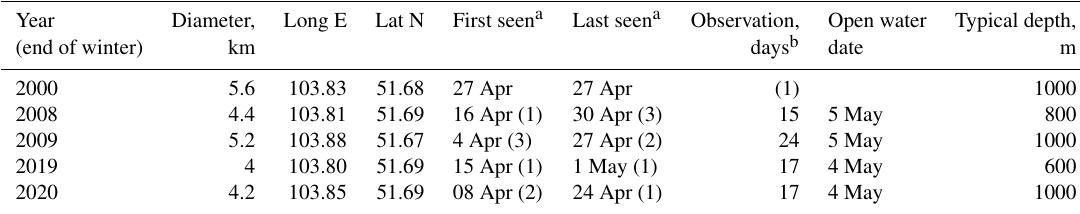
Table 2. Inventory of all ice rings detected so far in the Kultuk Bay and their characteristics. For the method used to define ice rings and the previous inventory, see Kouraev et al. (2016, 2019).